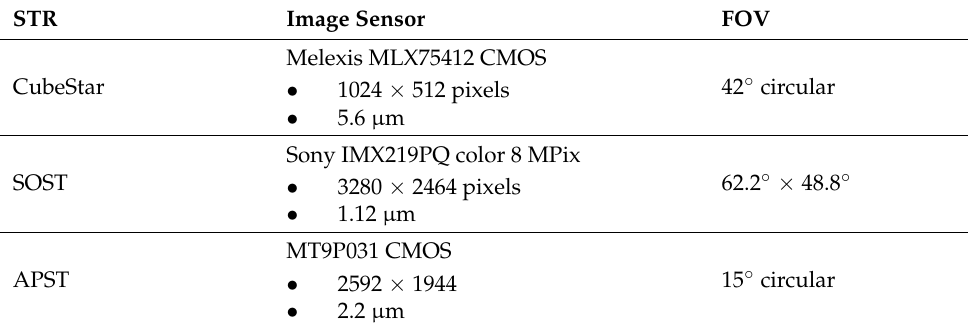
Table 1. STRs with COTS